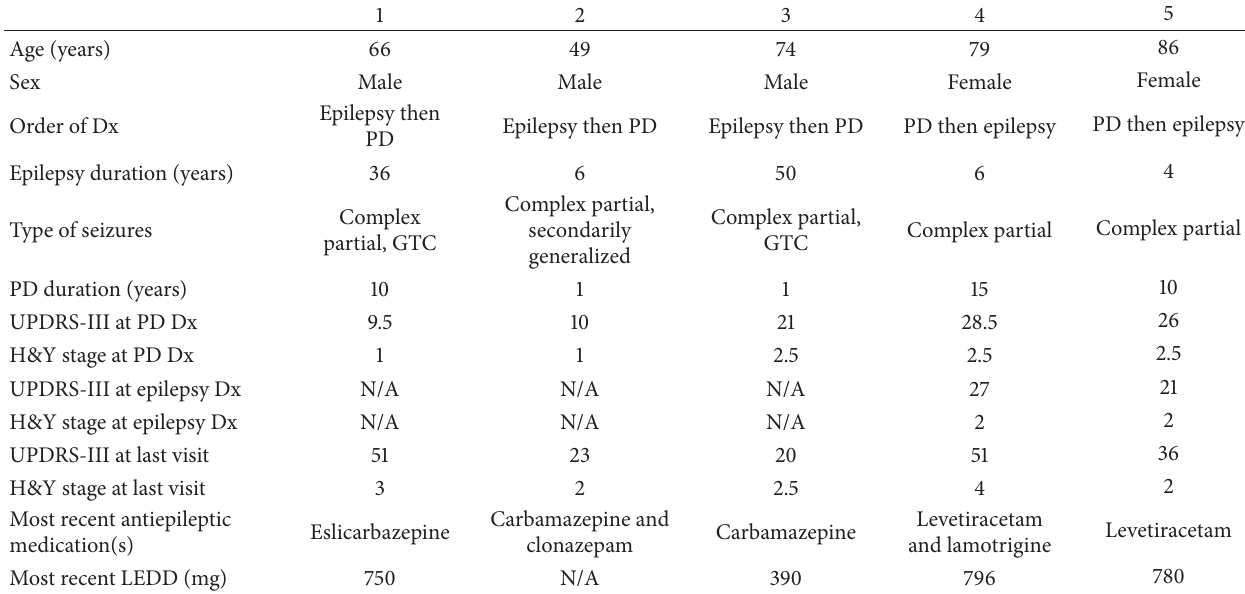
Table 1: Clinical and demographic